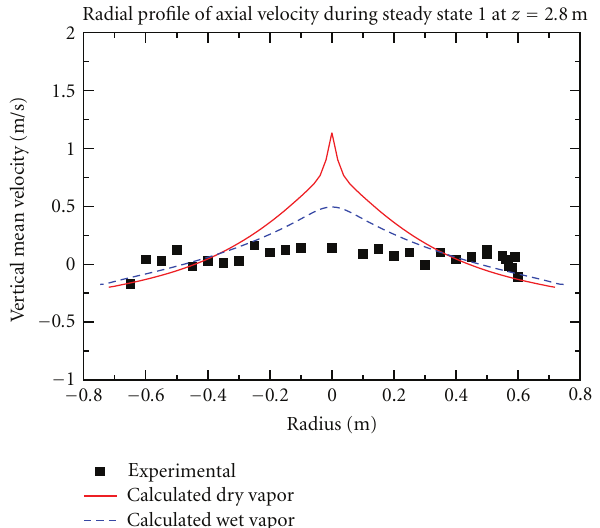
Figure 6: Radial profile of the steam molar concentration at Z 5 = 1 . 9m and Z 13 = 3 . 93 m: steady state